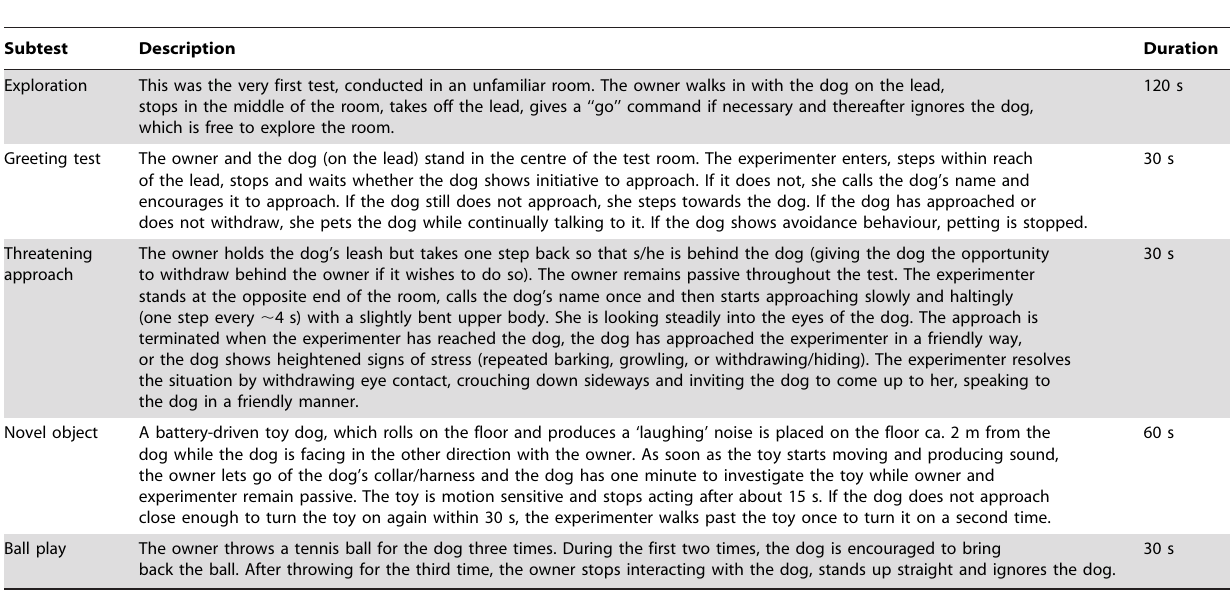
Table 5. Summary of the subtests of the adult test that were used for analysis.